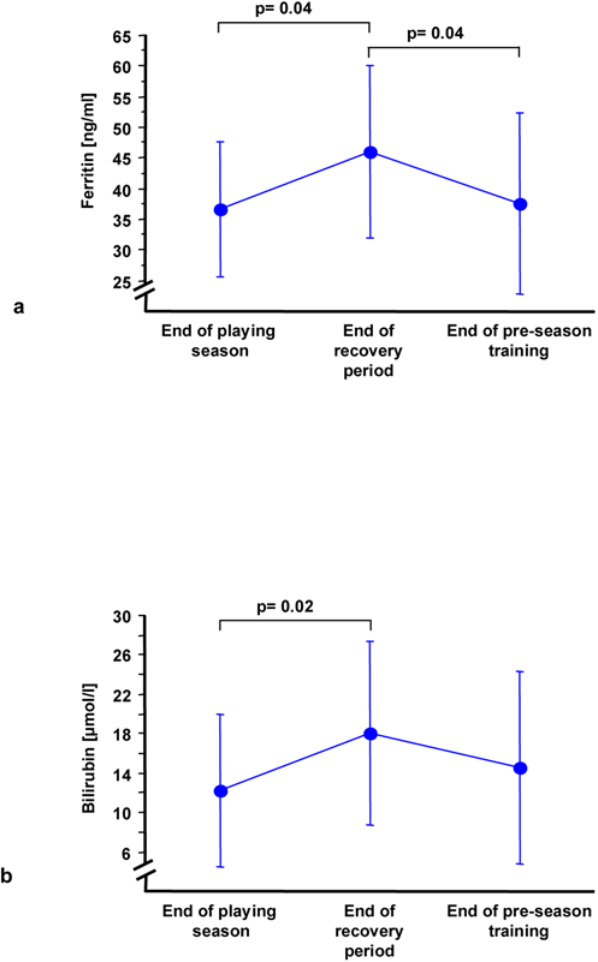
Figure 5. Increased (a) ferritin and (b) bilirubin concentrations during recovery both demonstrate enhanced HO-1 activity.